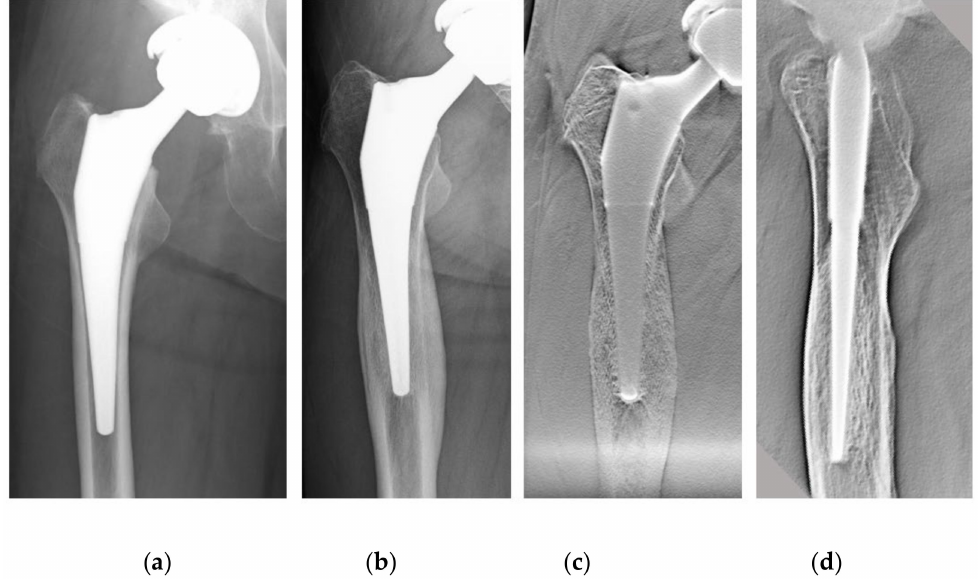
Figure 1. A 61-year-old female patient after THA using a tapered wedge stem. ( a ) Plain radiographs one month after THA. ( b ) The same patient 6 y later. There was cortical hypertrophy at Gruen Zones 3 and 5. ( c ) DTS (AP view) at the same time as ( b ). Cortical hypertrophy was observed more clearly. ( d ) DTS (lateral view) at the same time as ( b ). Heterogeneous loss of permeability is seen in the cancellous bone distal to the porous coating. THA, total hip arthroplasty; DTS, digital tomosynthesis; AP,